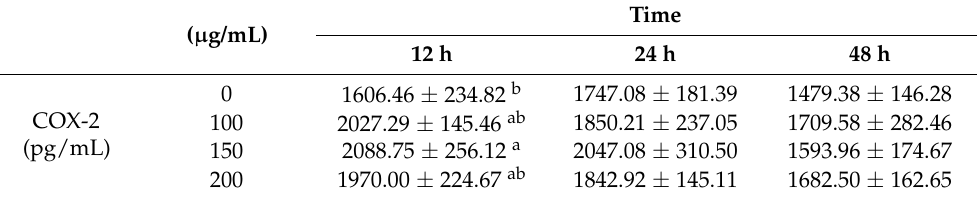
Table 7. Effect of different concentrations of GSP on COX-2 levels in mature adipocytes.